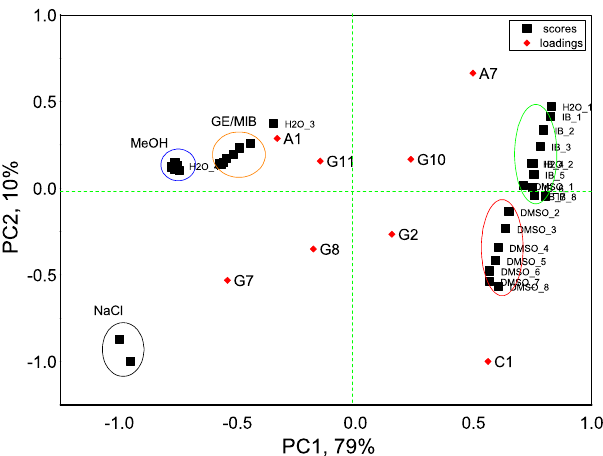
Figure 4. Principal component analysis (PCA) bi-plot result of E-tongue application for recognition of IB, DMSO, GE/MIB, and MeOH aqueous solutions in concentration range from 25 ng/L to 300 μ g/L. The numbers in the sample labels correspond to the progressive measurement number.